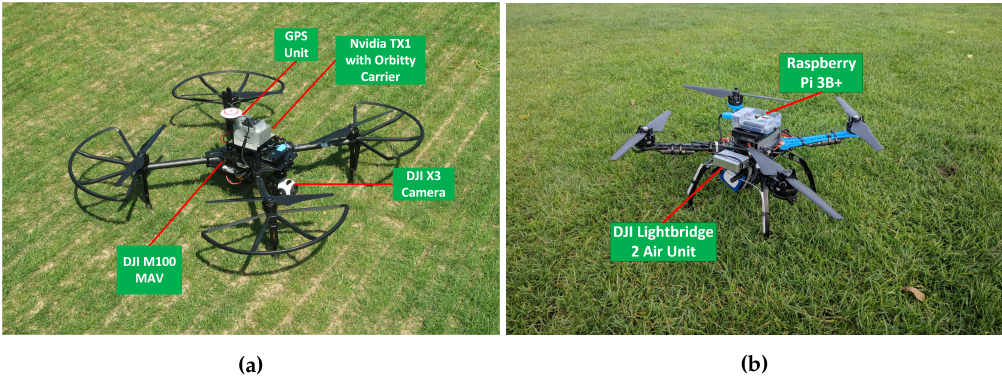
Figure 1. The UAV platforms; DJI M100 ( a ) and the custom quadcopter ( b